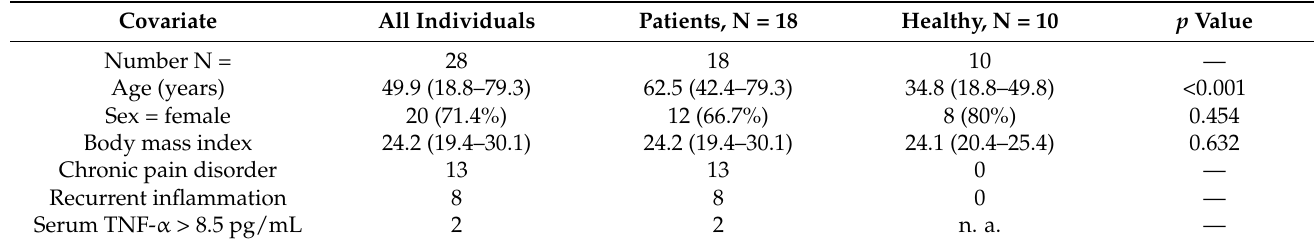
Table 1. Biometric data of patients and healthy individuals.